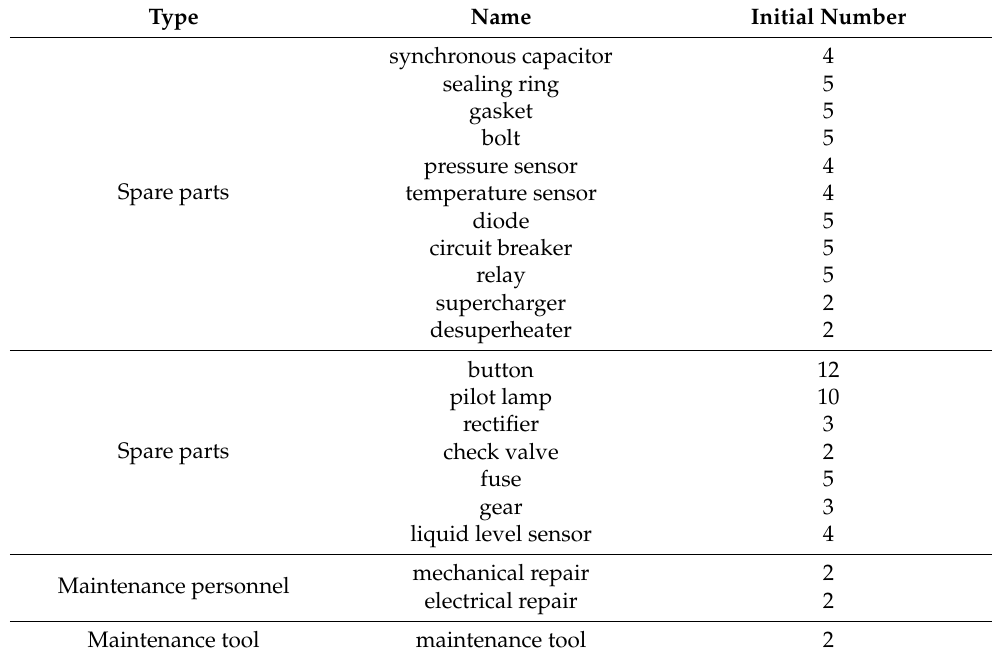
Figure 13. Equipment reliability structure in the simulation system. Table 5. Support resource in the simulation system.